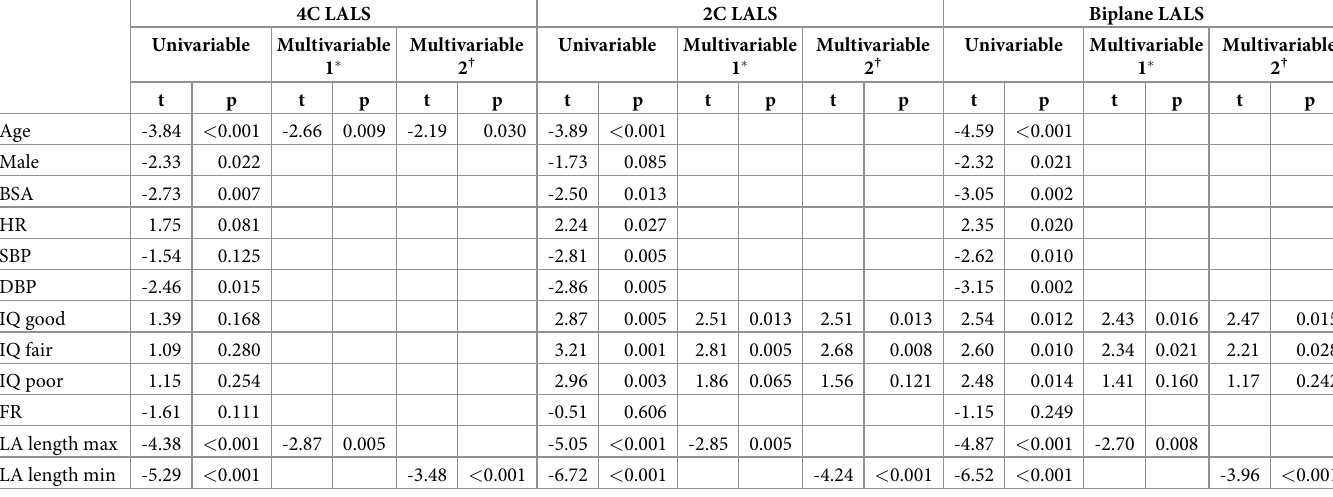
Table 2. Univariate and multivariate linear regression analysis for the association of anthropometric and echocardiographic parameters with left atrial longitudinal strain assessed with 2D echocardiography in 105 normal